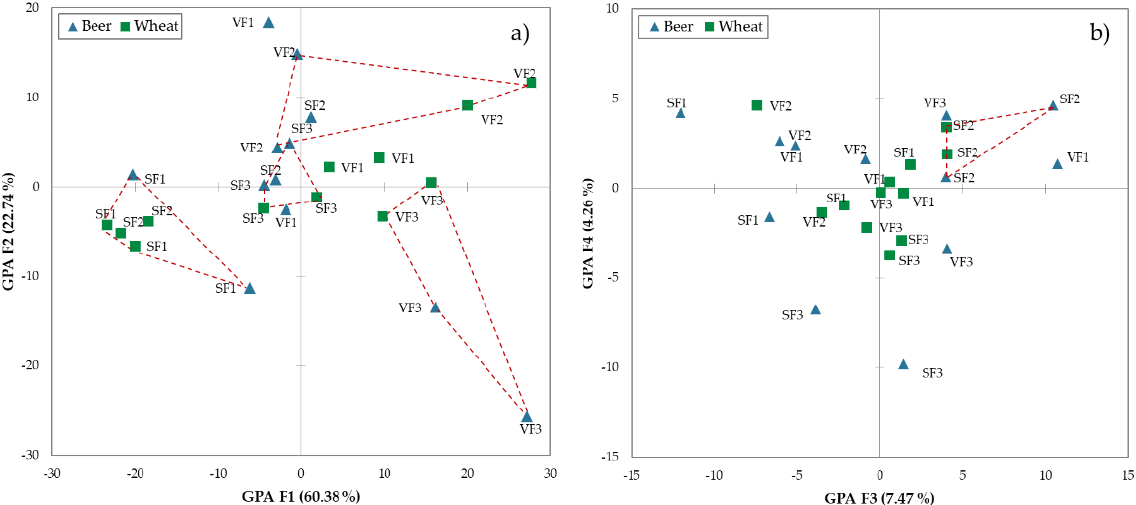
Figure 2. Consensus map, presented by configuration (wheat kernels and wheat beers), obtained by GPA along the F1 and F2 components ( a ); F3 and F4 components ( b ). Score nomenclature: (V) Vit- torio wheat; (S) Solina wheat; F1: 70 m a.s.l.; F2: 500 m a.s.l.; F3: 1200 m a.s.l.